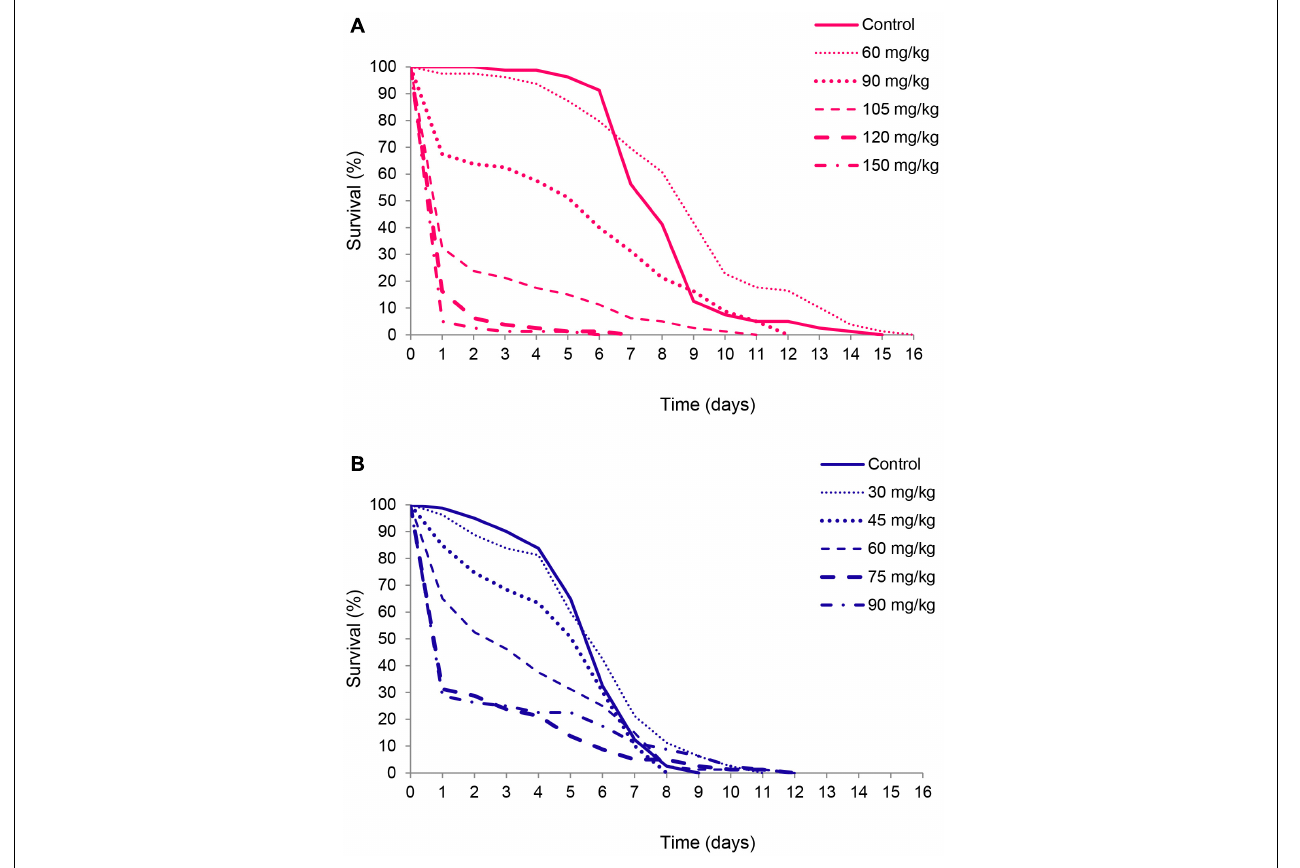
FIGURE 3 | Survival curves for female (A) and male Acanthoscelides obtectus (B) exposed to different thymol